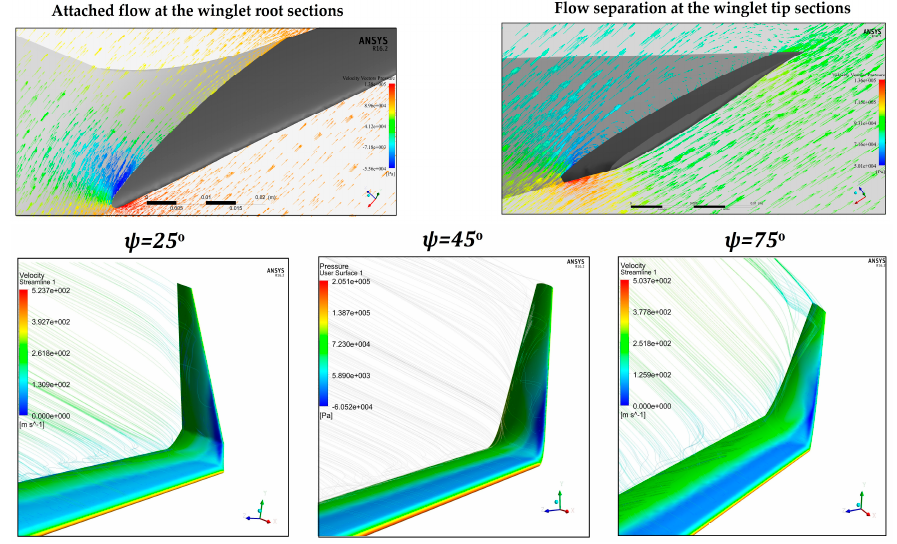
Figure 13. Pressure field and streamlines over winglets with different cant at a high angle of attack α = 4° and M = 0.8, Velocity vectors in section planes reveal attached flow at the winglet root versus a flow separation and a visible tip vortex occurring at tip sections of highly canted winglets.